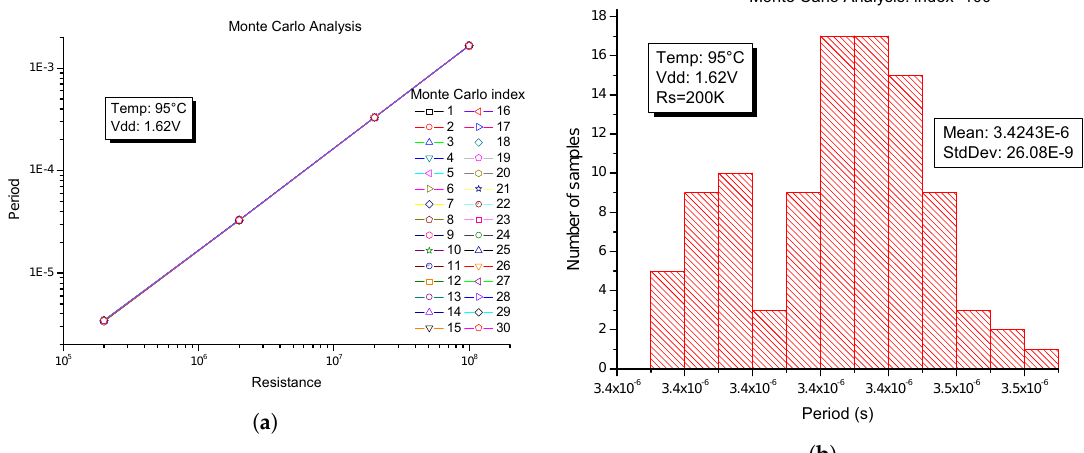
Figure 8. Monte Carlo analysis with sigma = 3: ( a ) output period vs. R s ; and ( b ) histogram at R s = 200 K Ω .